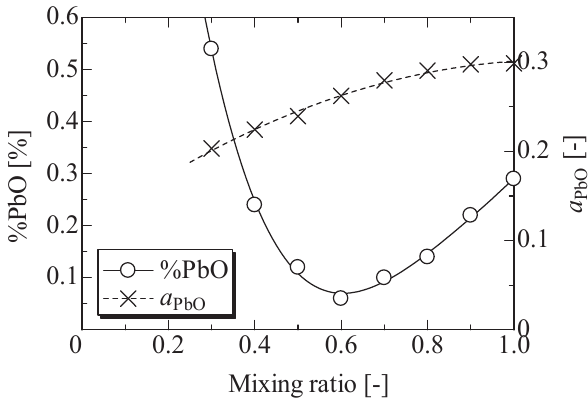
Figure 7. Changes in the PbO content and activity with the mixing ratio.